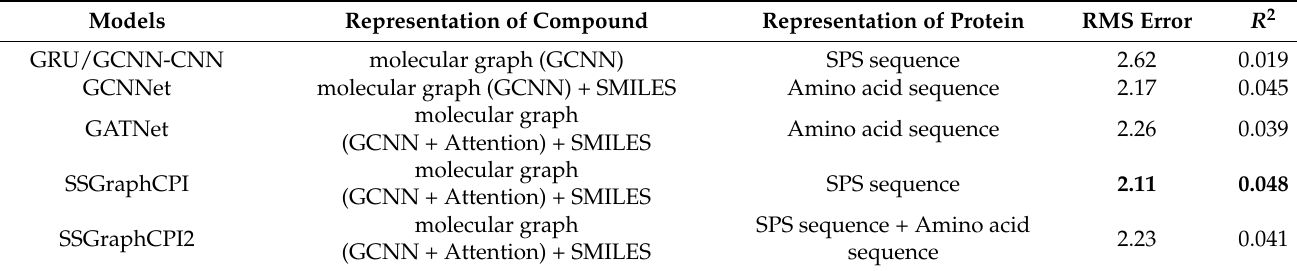
Table 3. RMS errors for different models on Channel dataset.